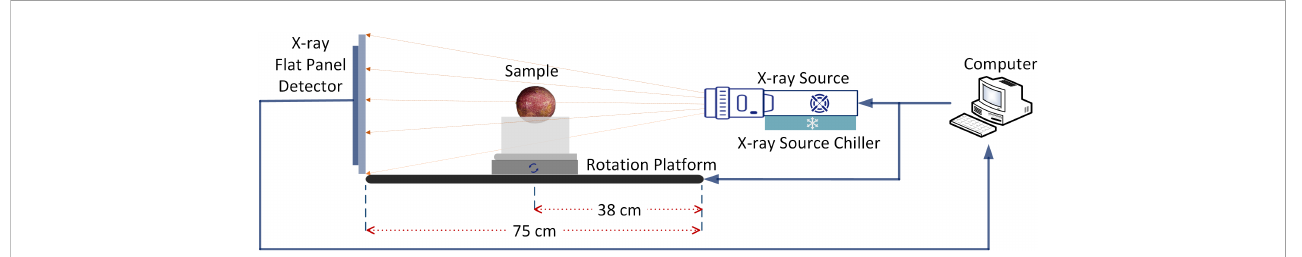
FIGURE 2 X-ray Micro-CT system schematic